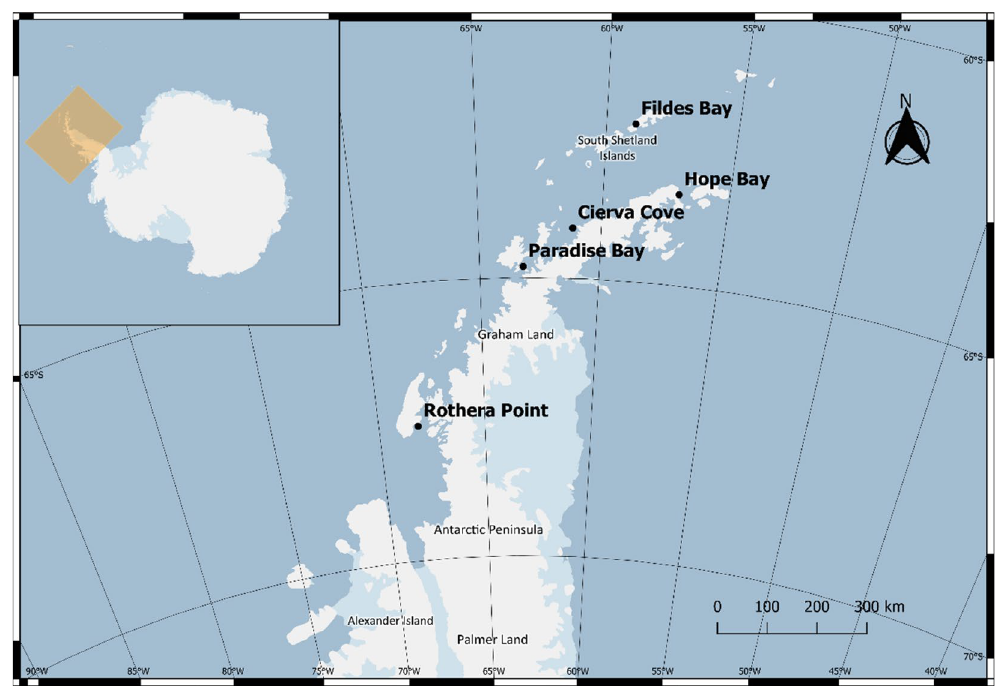
Figure 1. Study area and location of the sampling sites. The map was created using the Free and Open Source QGIS 3.16 software (http:// www. qgis. org/) and the Quantarctica 3.2 project (https:// www. npolar. no/ quant arcti ca/).